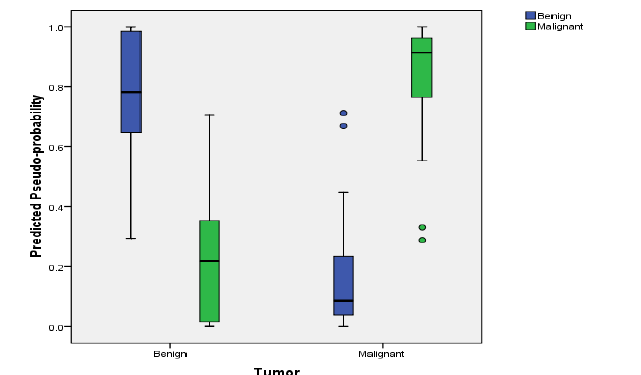
Fig. 4: Boxplot of the predicted pseudo probabilities of tumor